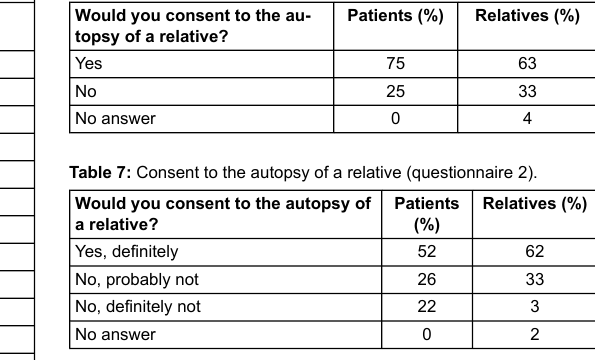
Table 3: Reasons against performing autopsies as seen by multimor- bid patients (n = 91) and their first-degree relatives (n = 55). What are reasons against per- forming autopsies?